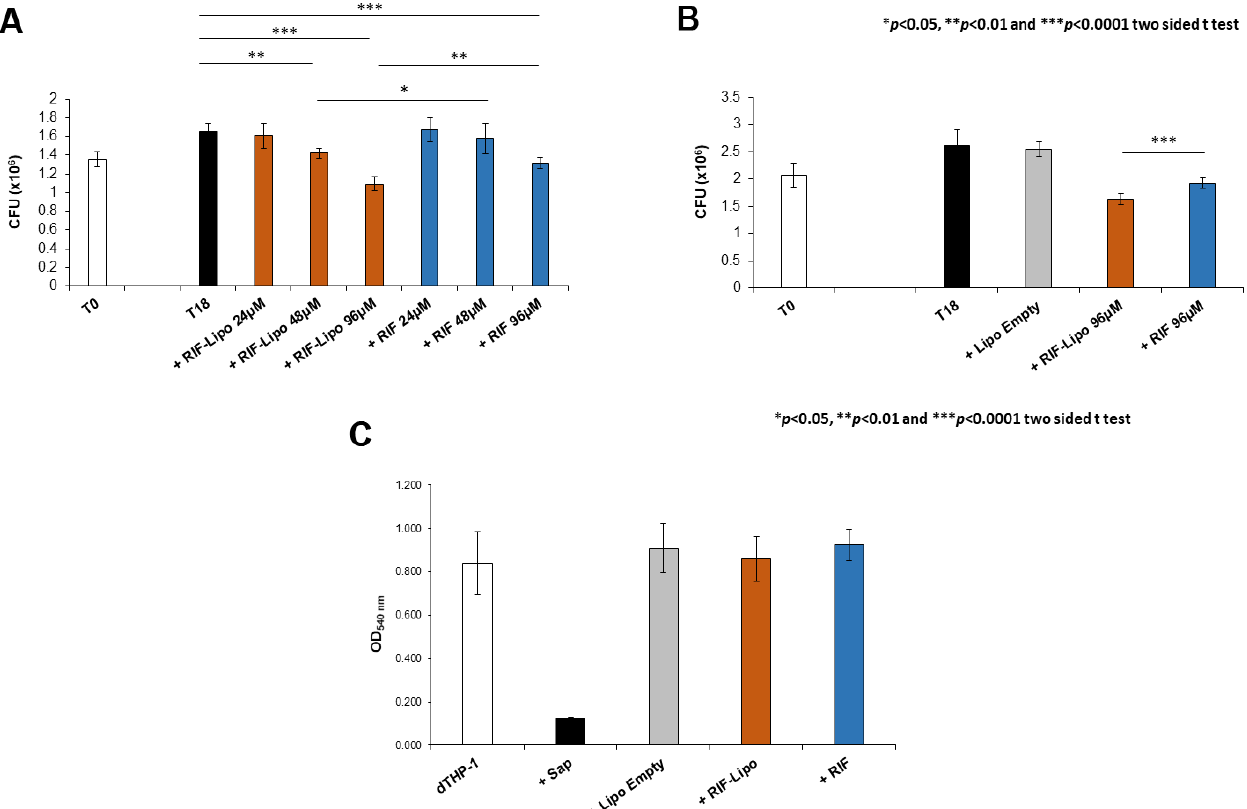
Figure 5. Intracellular mycobacterial killing is improved by rifampicin-loaded liposomes with no cytotoxicity effect. dTHP-1 (5 × 10 5 cells/mL) were infected with M. abscessus (MOI 10) for 3 h and the extracellular bacilli were killed with 250 µ g/mL Amikacin for 1 h. ( A ) Cells were treated for 18 h with RIF-loaded liposomes (RIF–Lipo) and free drug (RIF) at different concentrations and bacterial growth was quantified by CFU assay. Results are shown as mean ± standard deviation (SD) of CFU values obtained from triplicate cultures and are representative of three independent experiments. ( B ) Cells were treated with unloaded liposomes (Lipo Empty), 96 μ M rifampicin-loaded liposomes (RIF–Lipo) and 96 μ M free drug (RIF) for 18 h, and bacterial growth was assessed by CFU assay. Results are shown as mean ± SD of CFU values obtained from triplicate cultures and are representative of three independent experiments. * p < 0.05, ** p < 0.01 and *** p < 0.0001 by two sided Student’s t -test. ( C ) Liposome formulations and rifampicin do not exert cytotoxicity on macrophages. dTHP-1 (2 × 10 5 cells/200 μ L) were stimulated with unloaded liposomes (Lipo Empty), 96 μ M rifampicin- loaded liposome (RIF–Lipo) and 96 μ M free rifampicin (RIF) for 18 h and then were subjected to MTT Assay. Cells were treated with 0.1% saponin at 37 °C for 30 min as negative control (Sap). Results are shown as mean ± standard deviation (SD) of OD 540nm values performed in triplicate and are representative of three independent experiments. Finally, to assess the capability of RIF-loaded liposomes to be internalized in macrophages, and hence to be active against intracellular bacteria, RIF-loaded and unloaded liposomes, containing or not calcein, were prepared, dialyzed to remove free rifampicin and calcein, and used to stimulate dTHP-1 cells. Figure 6 shows that cells exposed to dialyzed RIF-loaded and unloaded liposome formulations show a similar pattern of fluorescence (Figure 6A), indicating that both liposome formulations were efficiently internalized by macrophages (Figure 6B).